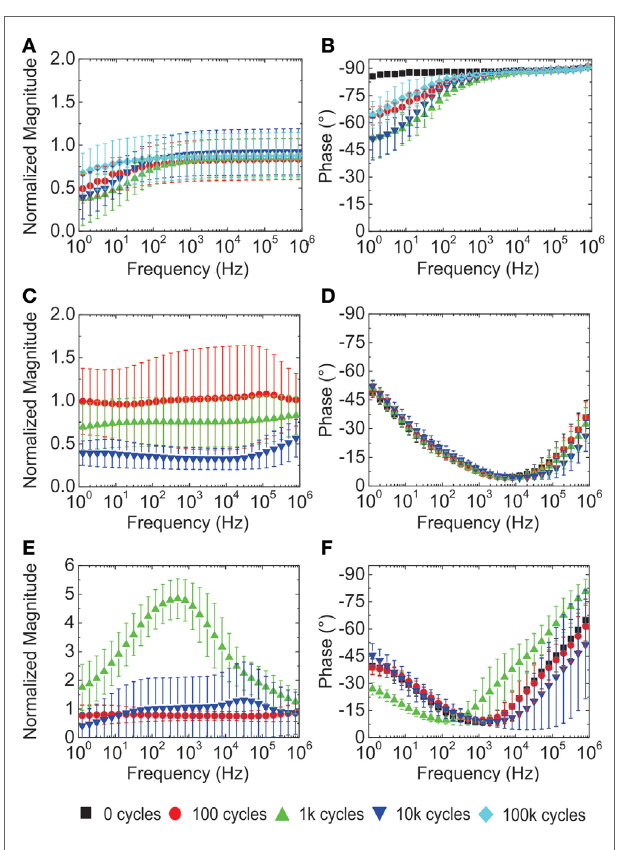
FigUre 12 | Transverse impedance from (a,B) PMP, (c,D) PMaP, and (e,F) PaMaP Parylene cables (mean ± se, n = 16) . Magnitude was normalized with respect to the impedance at 0 cycles (PMAP and PAMAP devices were only bent for 10k cycles).